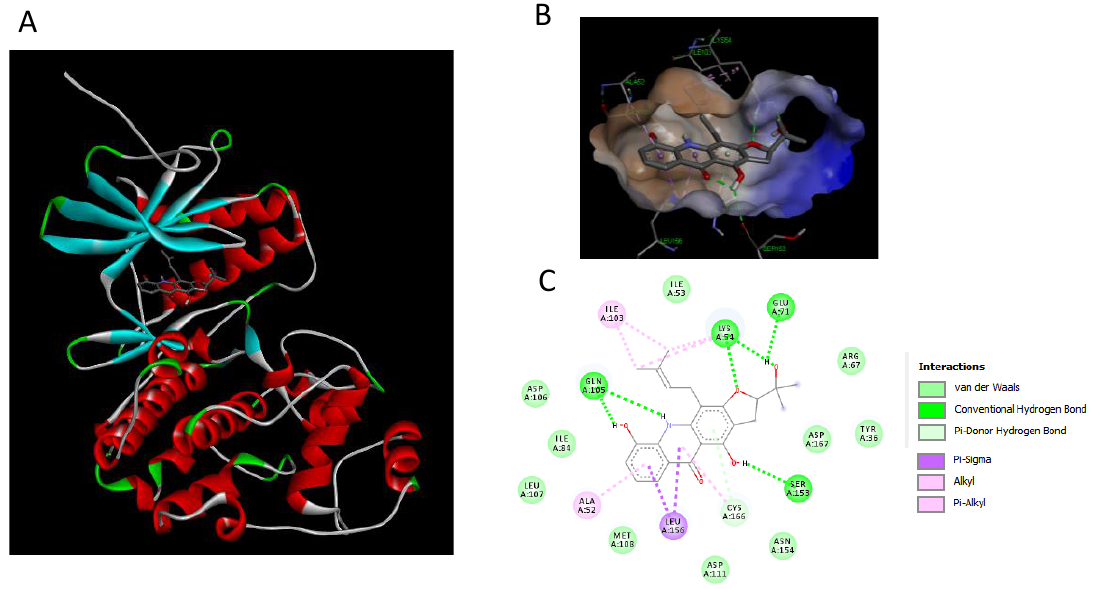
Figure 11. Binding modes and binding-interaction diagrams of buxifoliadine E bound to Erk. ( A ): buxifoliadine E bound at the ATP-binding site of Erk; ( B ): binding interaction between buxifoliadine E and Erk; ( C ): binding-interaction diagrams of buxifoliadine E and Erk.